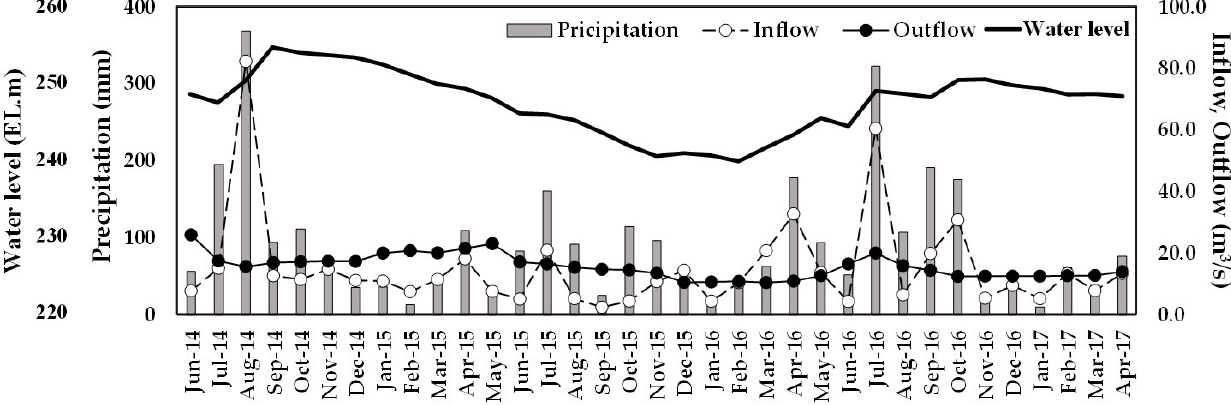
Figure 2. Inflow, outflow, and water level of Yongdam Reservoir and monthly precipitation in the surrounding area during this study.